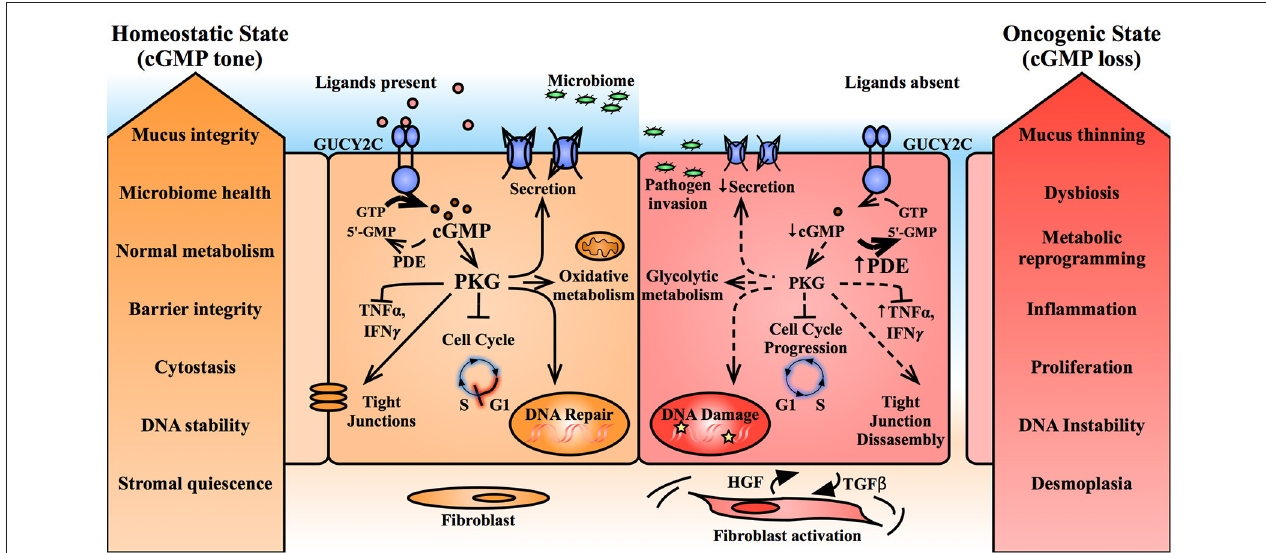
FIGURE 5 | Suppression of cGMP signaling promotes epithelial transformation. Basal cGMP tone in the intestinal epithelium promotes epithelial homeostasis. cGMP, through its effector, PKG, regulates several downstream mechanisms including mucus hydration, metabolism, inflammation, barrier integrity, DNA damage sensing, and cell cycle progression. In contrast, intestinal transformation is characterized by upregulation of phosphodiesterases and suppression of GUCY2C paracrine ligands, reducing intracellular cGMP and producing an epithelial phenotype predisposed to cancer progression. cGMP, cyclic guanosine monophosphate; GTP, guanosine triphosphate; GUCY2C, guanylate cyclase C; HGF, hepatocyte growth factor; IFN γ interferon gamma; PDE, phosphodiesterase; PKG, protein kinase G; TGF β , transforming growth factor beta; TNF α tumor necrosis factor alpha; 5 ′ -AMP, 5 ′ -adenosine monophosphate; 5 ′ -GMP, 5 ′ -guanosine monophosphate.